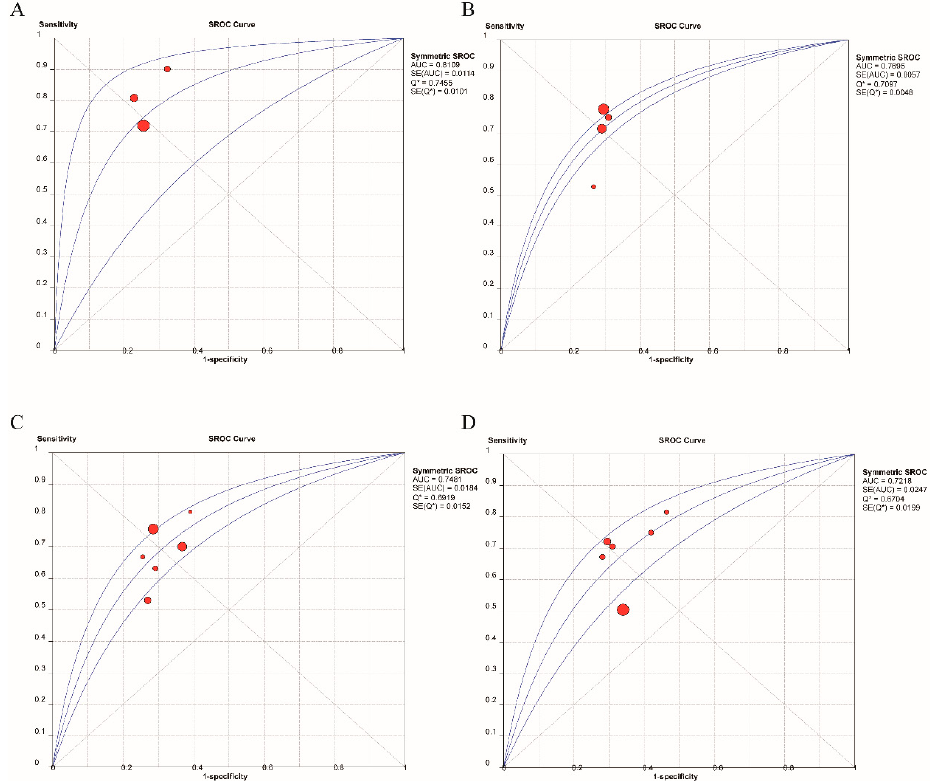
Figure 5. SROC curve with 95% confidence region and prediction region for the diagnosis of MAFLD. ( A ) cut off value with TyG < 6. ( B ) cut off value with 6 ≤ TyG < 8. ( C ) cut off value with 8 ≤ TyG < 8.5. ( D ) cut off value with TyG ≥ 8.5 (AUC: area under curve).